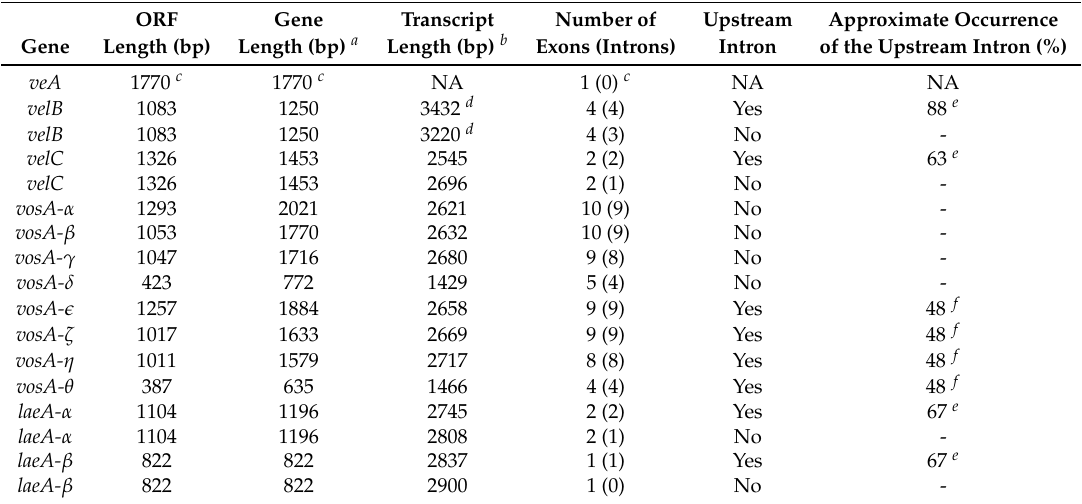
Table 2. Sequenced transcript details of the A. terreus MUCL 38669 velvet family with splice variants. ORF Gene Transcript Number of Upstream Approximate Occurrence Gene Length (bp) Length (bp) a Length (bp) b Exons (Introns) Intron of the Upstream Intron (%)